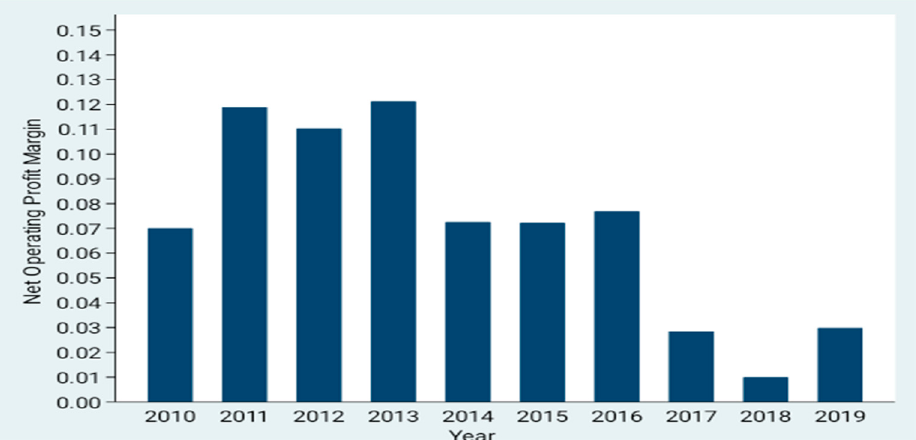
Figure 1. Trends in net operating profit margin